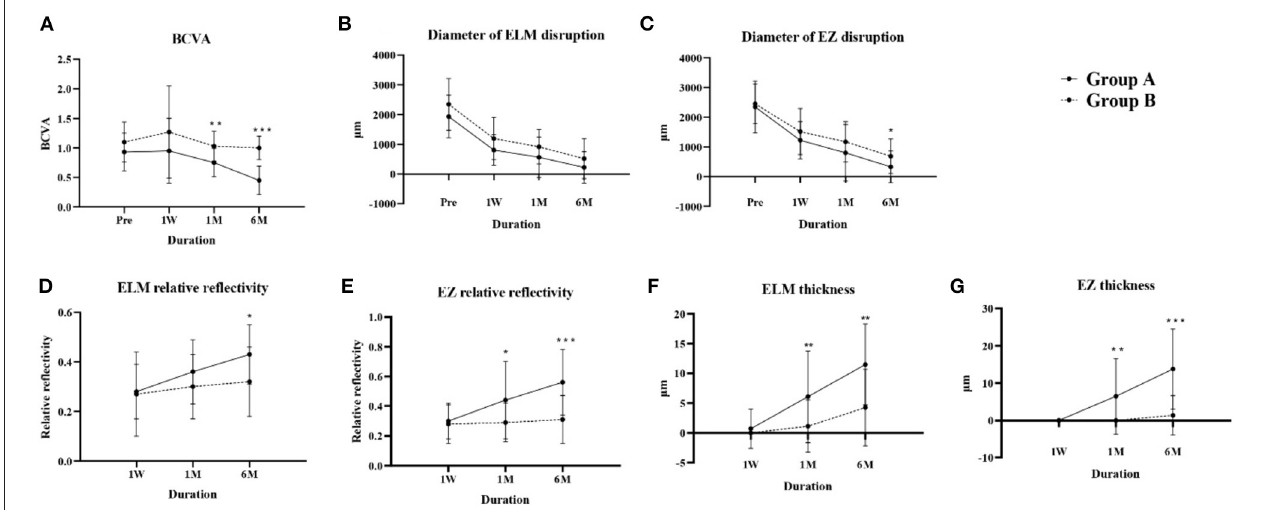
FIGURE 2 | Changes in parameters over time in groups A and B. (A) BCVA, (B) diameter of ELM disruption, (C) diameter of EZ disruption, (D) ELM relative reflectivity, (E) EZ relative reflectivity, (F) ELM thickness, (G) EZ thickness. BCVA, best-corrected visual acuity; ELM, external limiting membrane; EZ, ellipsoid zone. * P < 0.05; ** P < 0.01; *** P < 0.001.